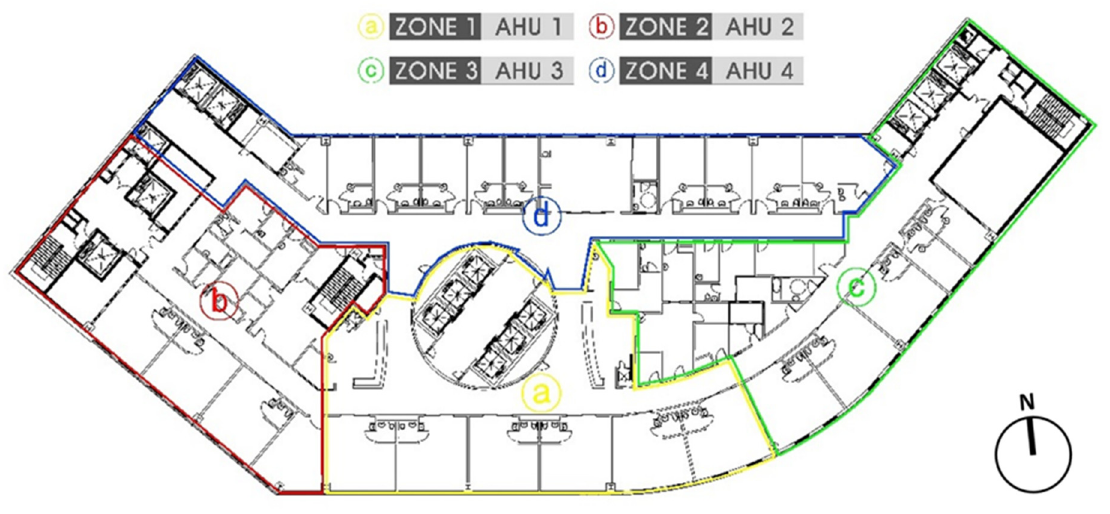
Figure 6. Case study building: typical floor plan and thermal zoning. Table 2. Air-handling units of the case study building.